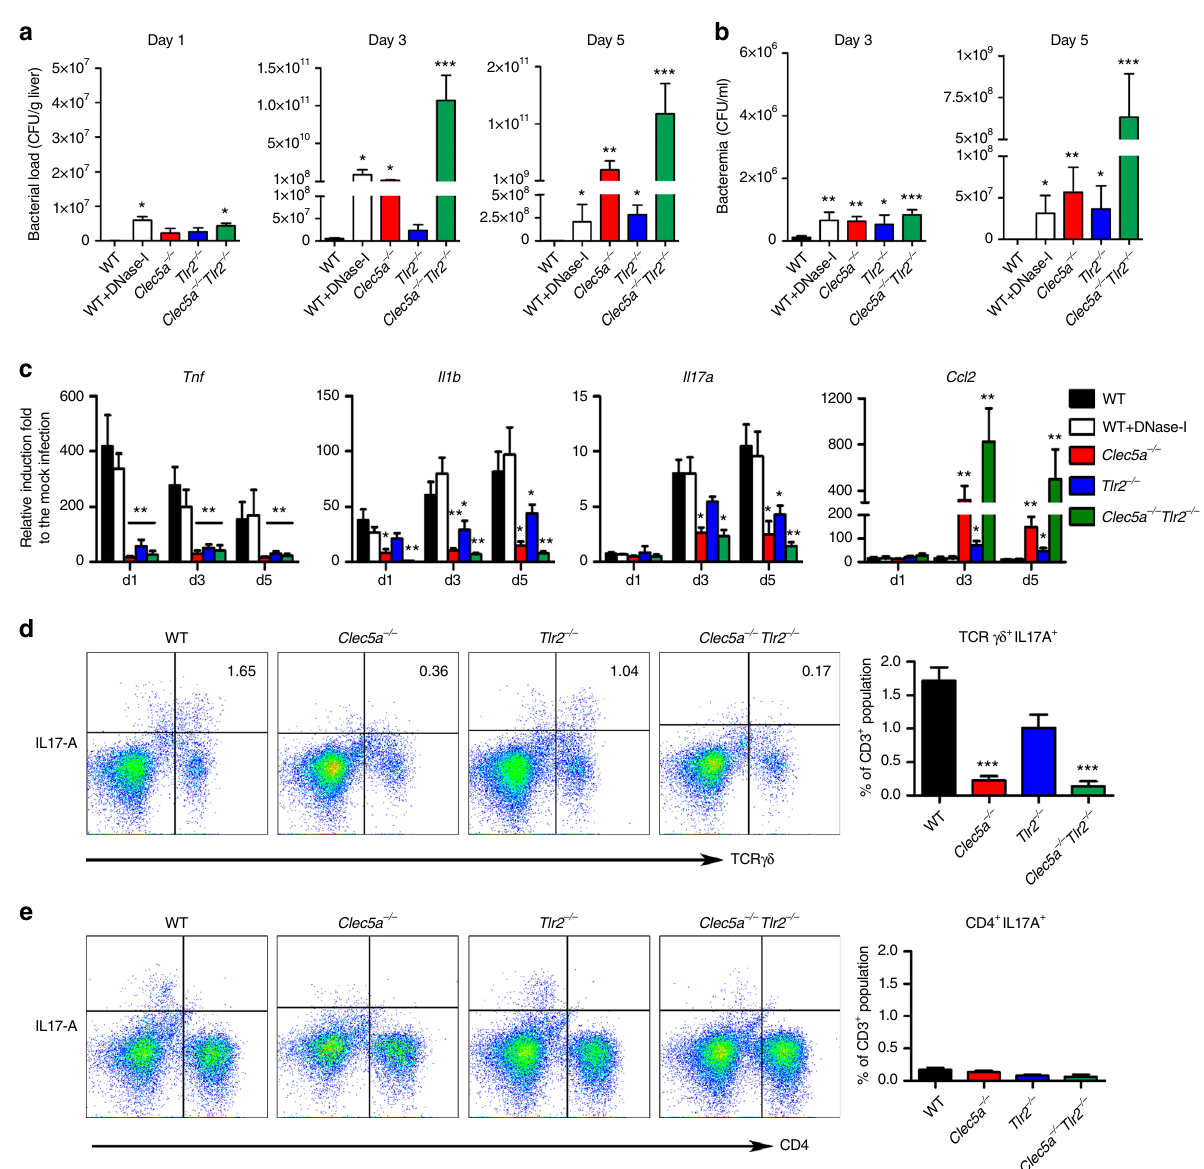
Fig. 4 CLEC5A and TLR2 collaborate to eliminate L. monocytogenes . a , b All groups of mice were intravenously challenged with 1 × 10 5 CFUs of L. monocytogenes (10403S), and the bacterial loads in the livers a and blood b were determined at days 1, 3, and 5 post-infection (20 mice per group). c Livers were collected and lysed in TRIzol to extract total RNA for reverse-transcription into complementary DNA ( cDNA ) at the indicated time point post-infection. The expression levels of Tnf , Il1b , Il17a and Ccl2 were determined by real-time PCR and normalized with Gapdh . The data were collected and expressed as mean ± s.e.m. from four independent experiments ( n = 20). One-way ANOVA was performed. * P < 0.05, ** P < 0.01, *** P < 0.001 for WT versus knockout mice, WT versus WT/DNase-I mice or indicated two groups. d , e Left : representative FACS plots of IL-17A-proudcing γδ T (CD3 + CD4 - TCR γδ + ) and Th17 (CD3 + CD4 + TCR γδ - ) cells under the CD3 + -gated population in mouse liver at day 5 post L. monocytogenes infection. Right : The data were collected from three independent experiments ( n = 9 for each − we concluded that the induction of IL-17A-secreting CD3 + CD4 TCR γδ + population during Listeria infection occurs via CLEC5A- dependent IL-1 β production from myeloid cells, rather than direct activation of CD3 + CD4 − TCR γδ + cells.